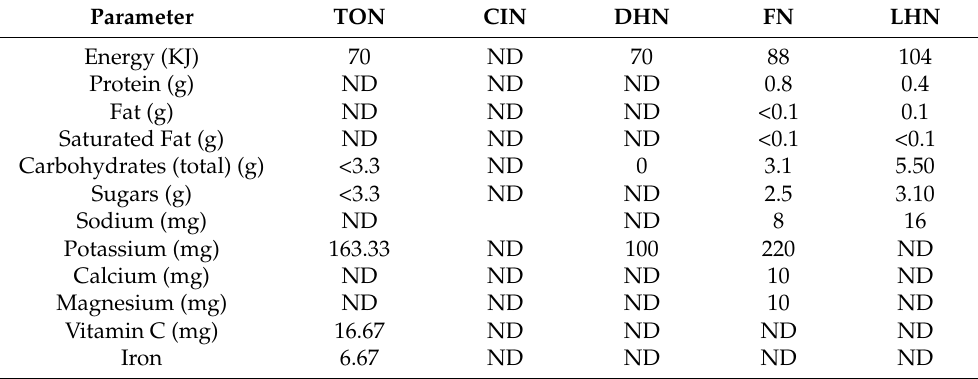
Table 2. Nutritional panel information for the commercial noni juice samples. Values are provided per 100 mL of